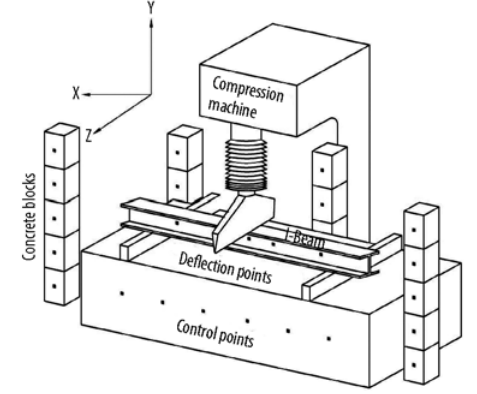
Fig. 1. The beam, loading, photogrammetric control points and locations of the deflection